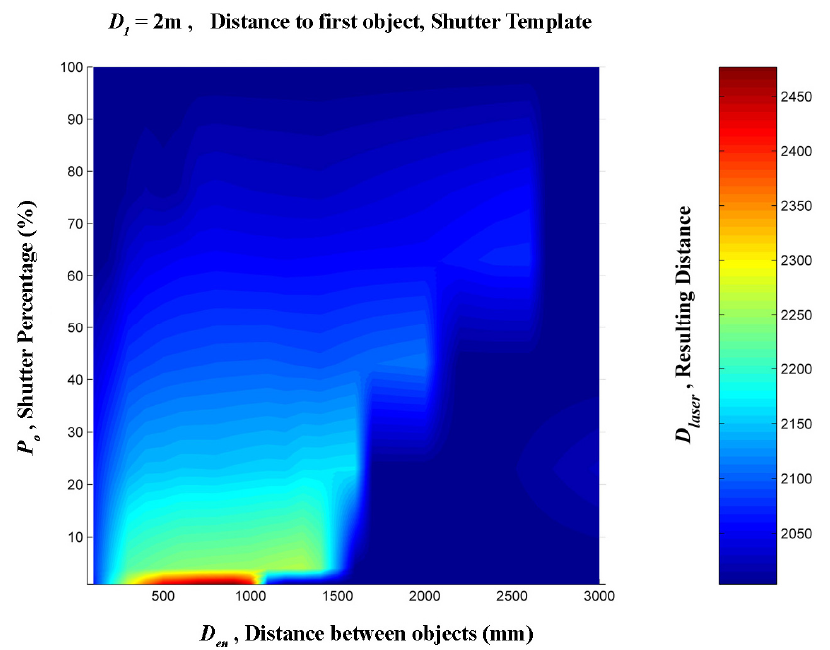
Figure 17. Graphic representation of the distance values (D the results of the progressive blockage of the beam at 90° with the shutter template at a distance (D ) of 2,000 mm from the sensor, with different values of D 1 and 3,000 mm.